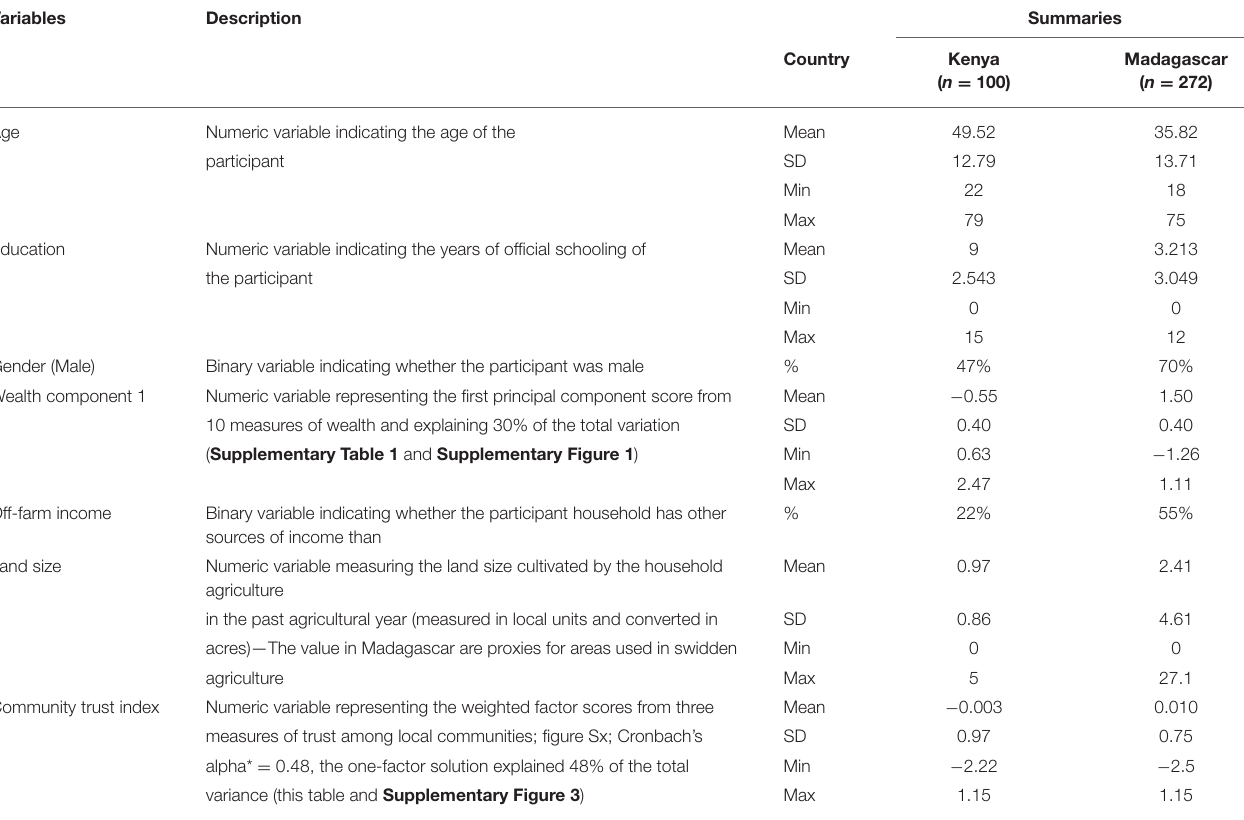
TABLE 2 | Descriptive statistics of predictor variables included in the